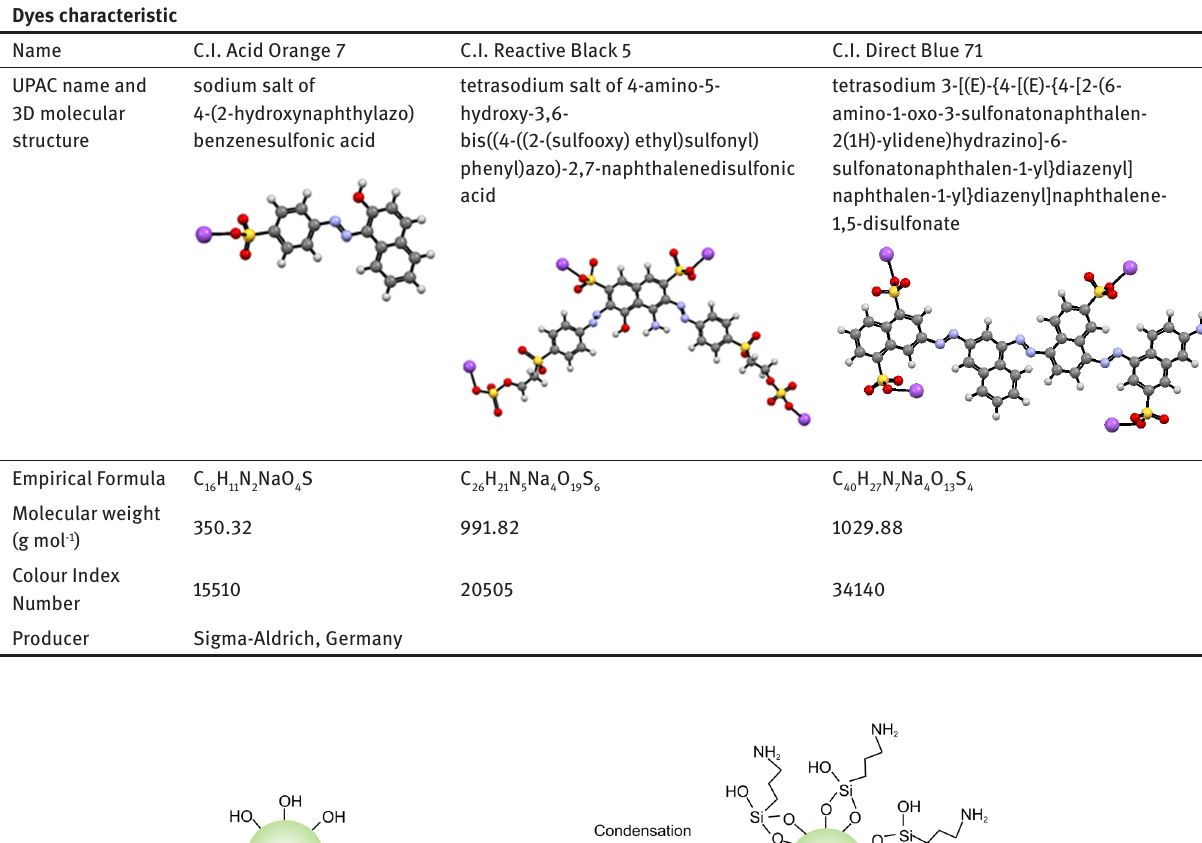
Table 2: Dyes properties. Dyes characteristic